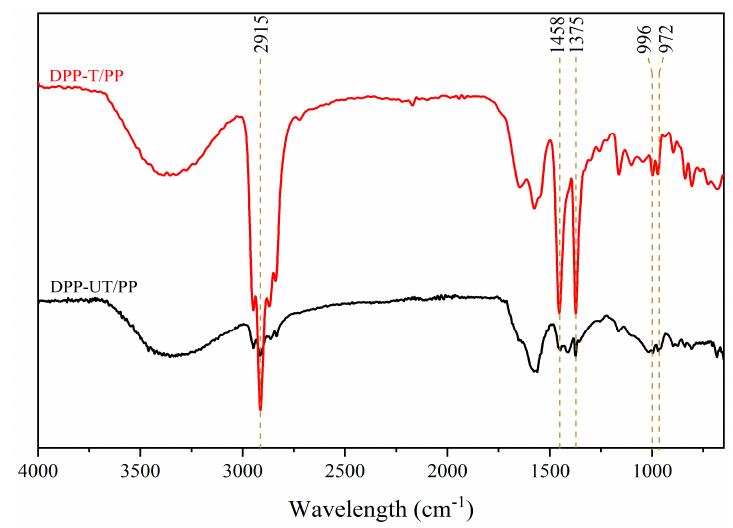
Figure 4. FTIR spectra of DPP-UT/PP and DPP-T/PP.